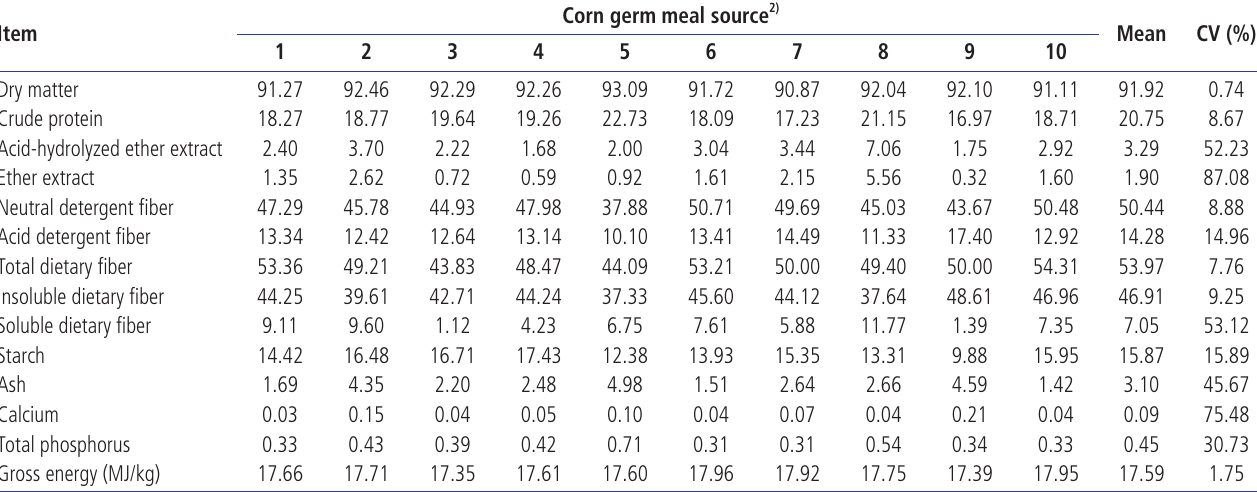
Table 2. Analyzed chemical compositions of corn germ meals used in the experiment (%, as-fed basis) 1)